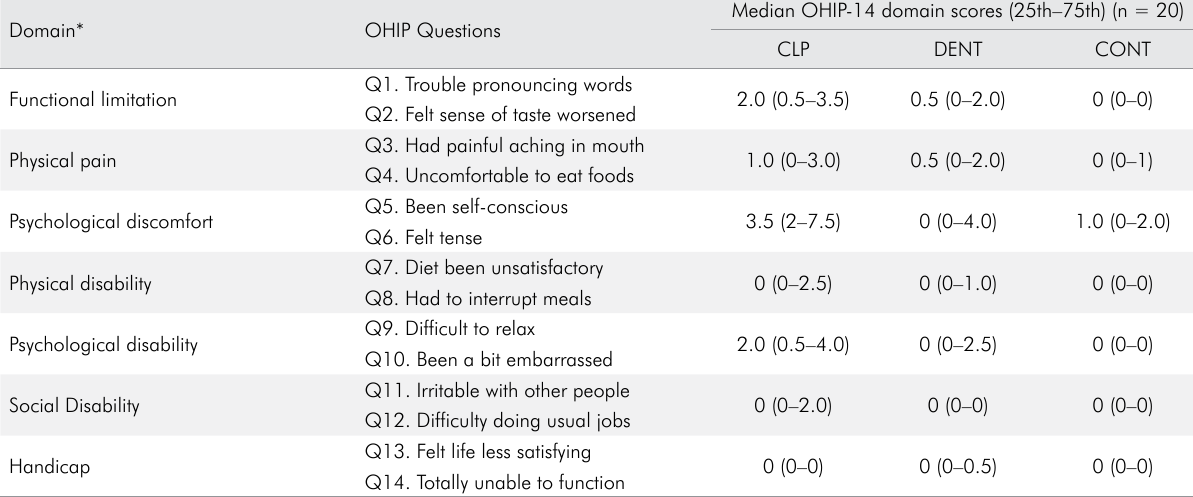
Table 2. Median scores in each OHIP-14 domain among groups.